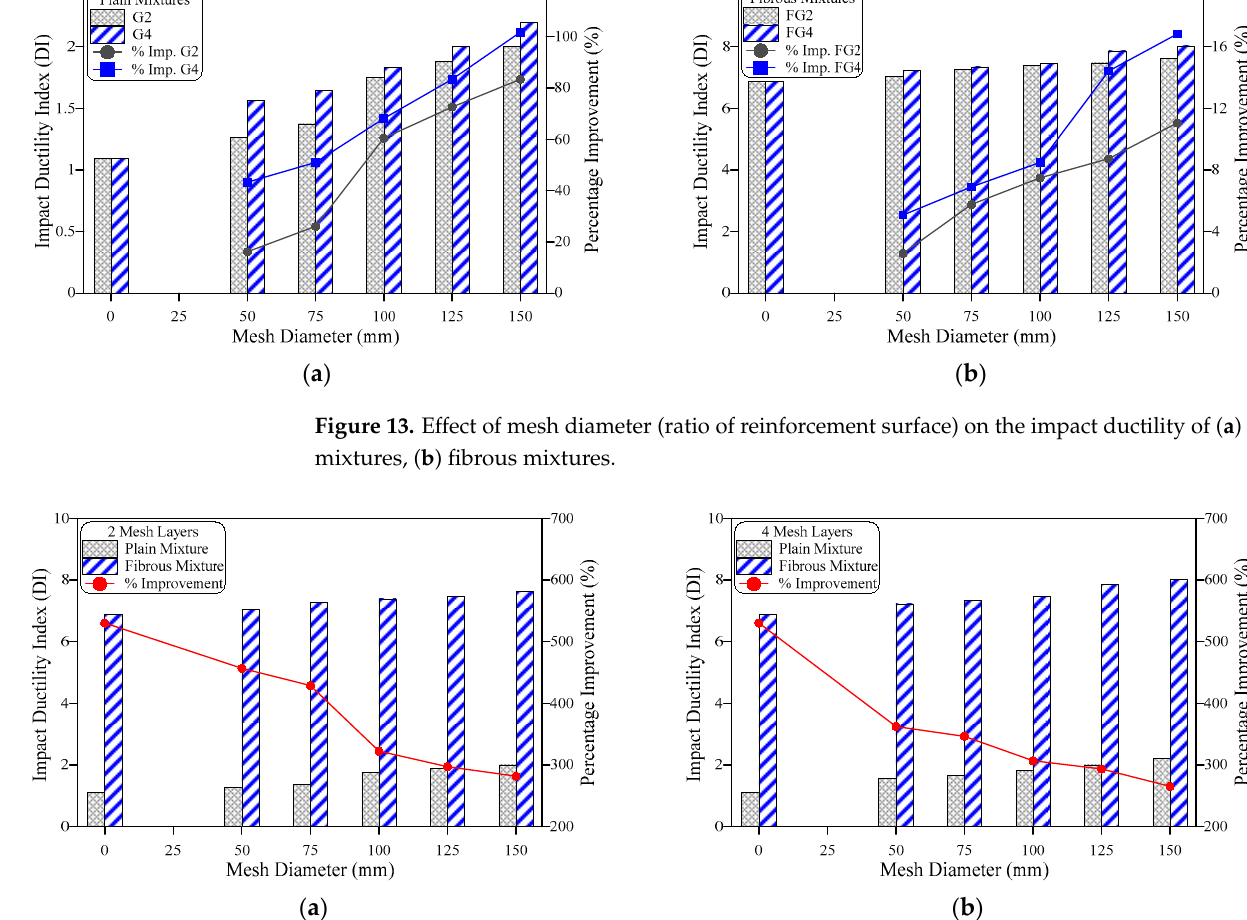
Figure 14. Effect of fiber on the impact ductility, ( a ) 2-mesh layers, ( b ) 4-mesh layers.